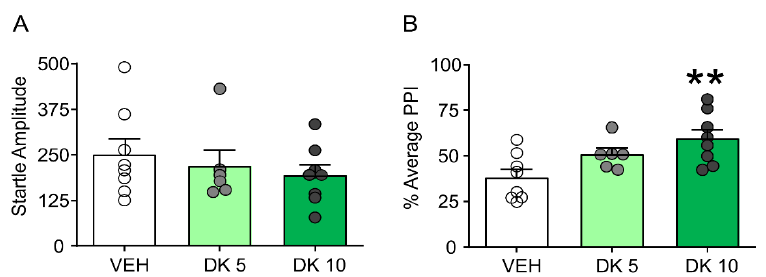
Figure 4. Effects of DK-I-56-1 (DK, 5, 10 mg/kg, IP) on ( A ) startle response and B) prepulse inhibition (PPI) ( B ) in D1CT-7 mice exposed to spatial confinement. DK had no effects on startle amplitude but restored PPI (F(2,19) = 6.05; p = 0.009). All analyses were performed by one-way ANOVAs. Significance refers to the results of post-hoc comparisons. ** p < 0.01. n = 6–8/group. For further details, see text.